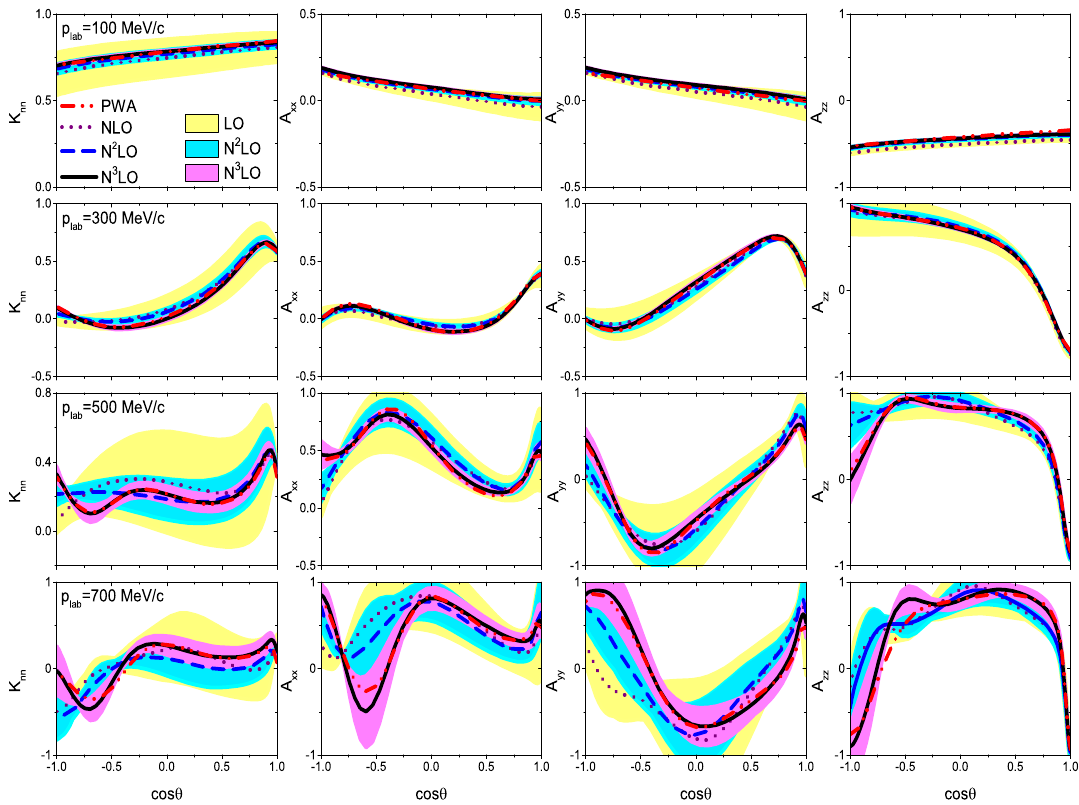
Figure 13 . Spin correlation parameters K nn , A xx , A yy , and A zz for charge-exchange scattering. For notations, see (cid:12)gure